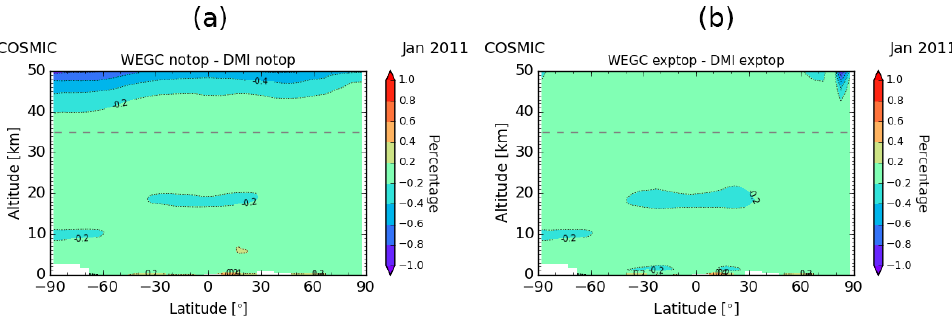
Figure 8. Difference between WEGC and DMI API refractivity climatologies for notop (a) and exptop (b) , exemplary for January